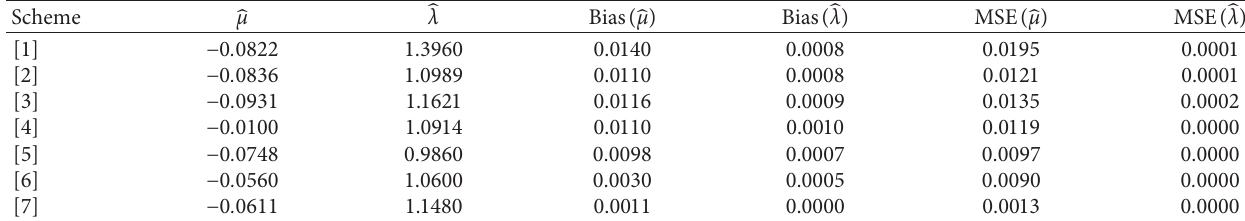
Table 6: MLEs 􏽢 μ , 􏽢 λ , biases, and MSEs for μ and λ from APE distribution when α � 1 . 5. Scheme